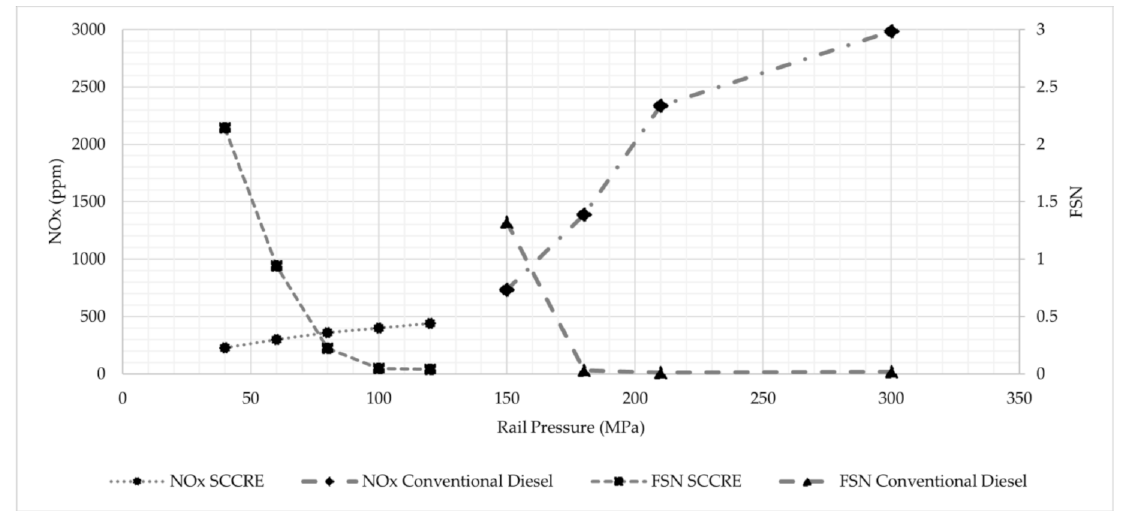
Figure 3. NOx and FSN vs. rail pressure from the SCCRE at 1200 RPM and 0.69 equivalence ratio (21 AFR) and from the Proteus at 1250 RPM and 0.66 equivalence ratio (22 AFR). SCCRE data adapted from Ref. [8] with permission. © SAE